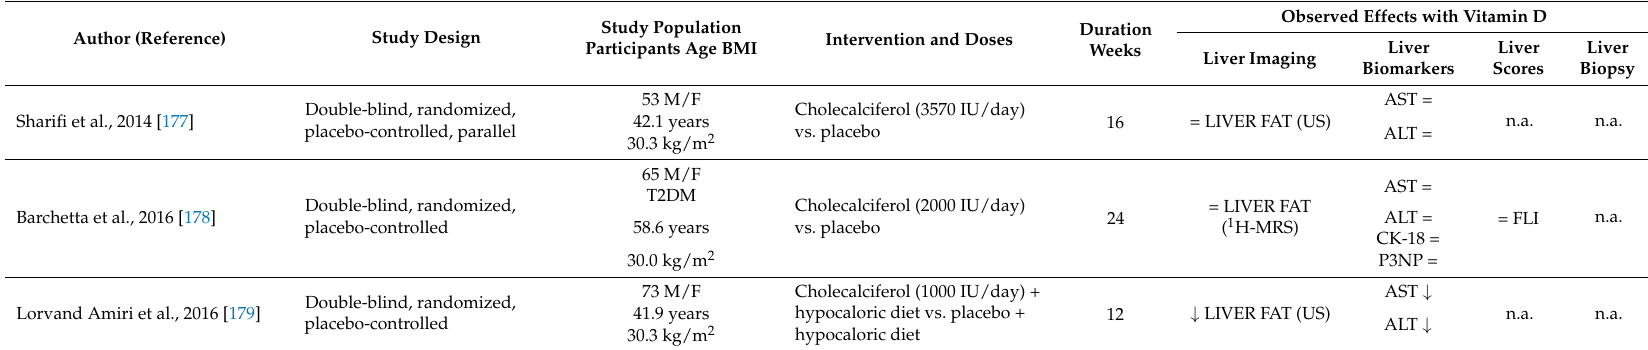
Table 6. Clinical trials on the effects of vitamin D supplementation on NAFLD in individuals at high cardiometabolic